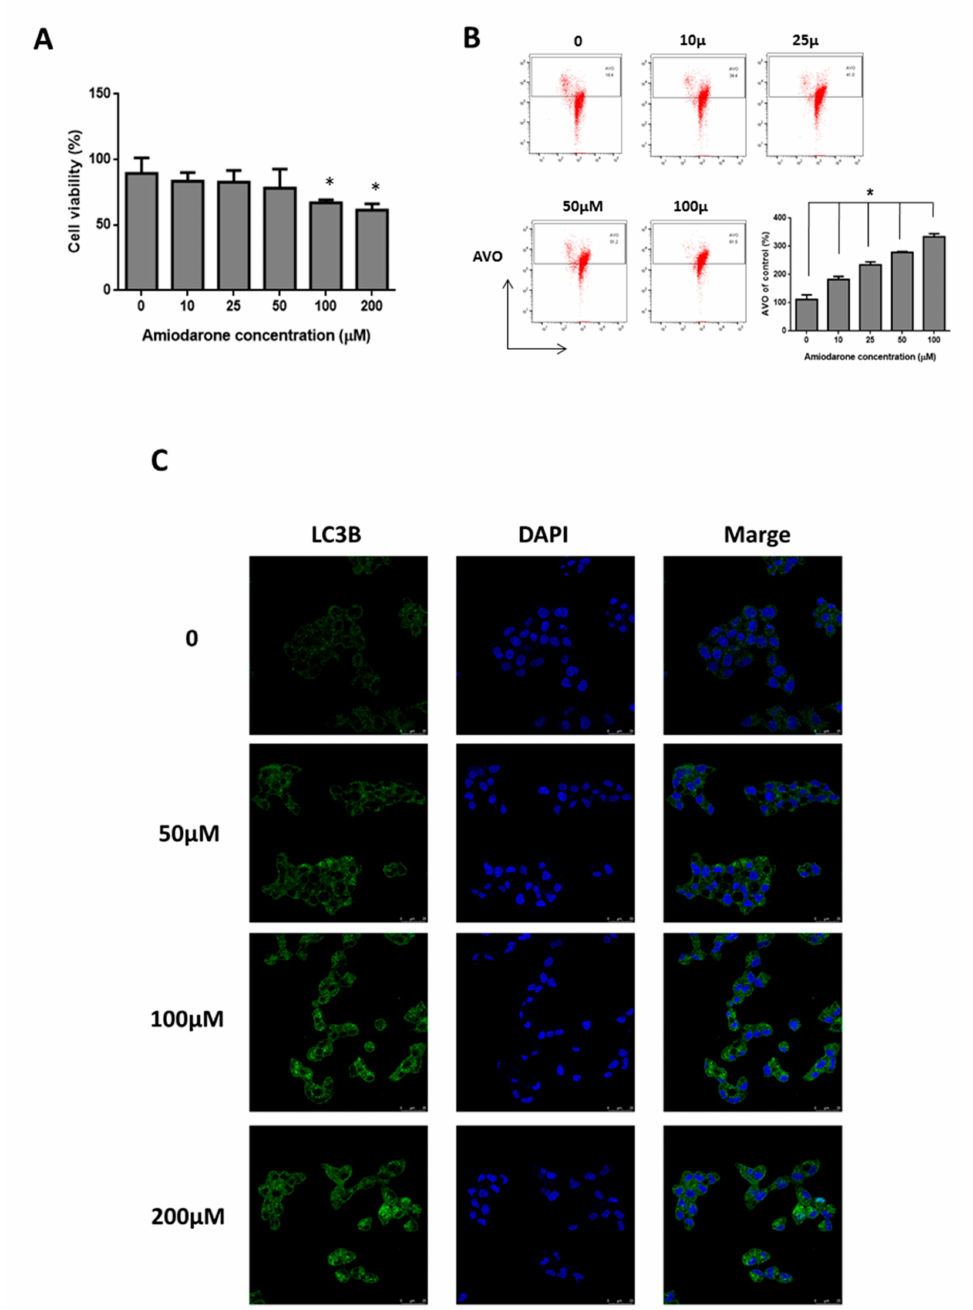
Figure 4. Amiodarone inhibited HepG2 cell growth through autophagy. ( A ) MTT assay for cell viability of HepG2 cells treated with various concentrations of amiodarone for 24 h. ( B ) Quantification of AVO formation in HepG2 cells. AVO induction was measured by acridine orange staining and the percentage of developed AVOs was analyzed by flow cytometry. LC3B puncta formation in HepG2 cells under ( C ) confocal microscope was examined. HepG2 cells were treated with various concentrations of amiodarone, as indicated, and subjected to immunofluorescence analysis of LC3B. Nuclei were stained with DAPI. The results are expressed as the means ± SD from three independent experiments ( n (cid:61) 3, * p < 0.05 compared with untreated